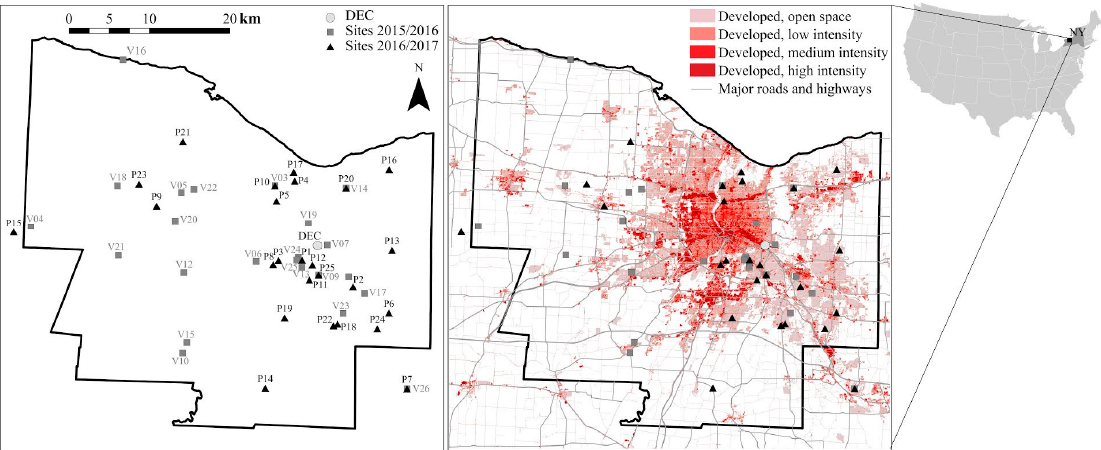
Figure 1. Speck units’ locations across the Monroe County, NY, during the two heating seasons. Background: Developed class defined in the USGS National Land Cover Database 2011.